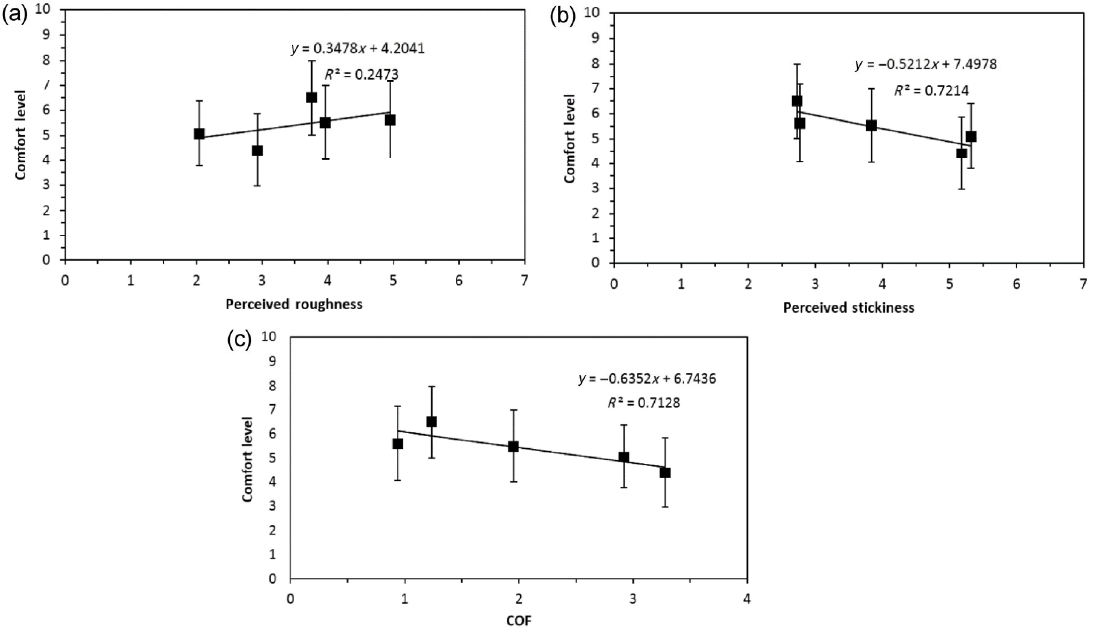
Fig. 10 Geometric mean of (a) comfort level versus perceived roughness; (b) comfort level versus perceived stickiness; (c) comfort level versus